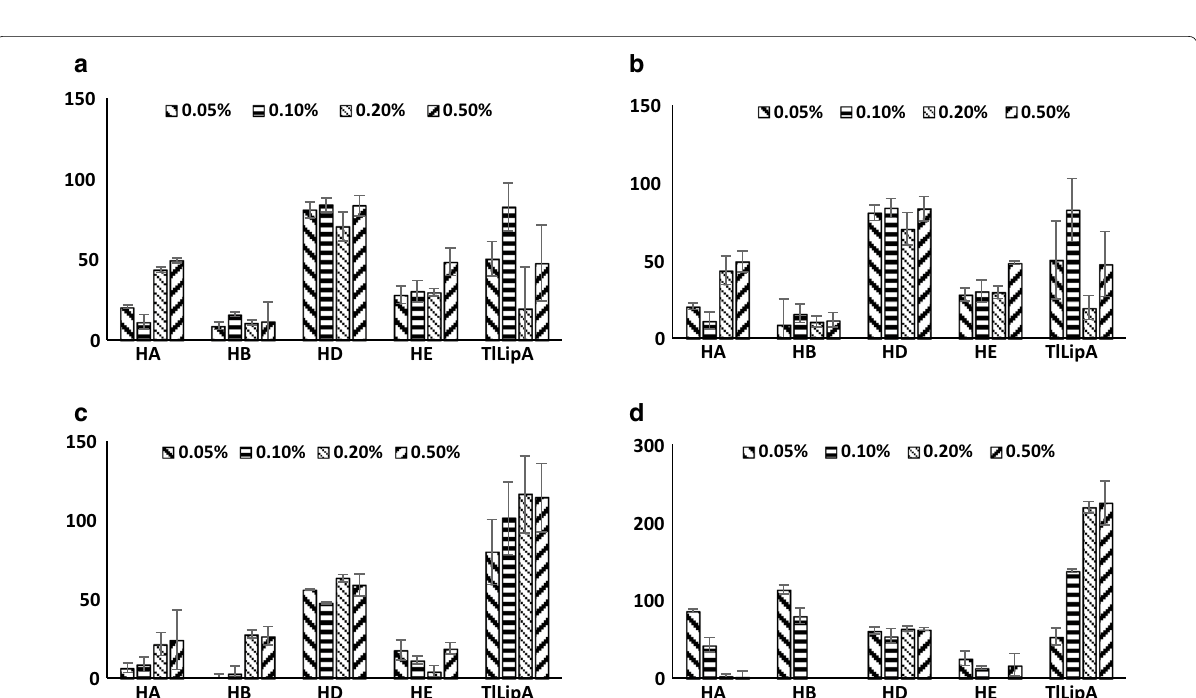
standard deviations (n ±